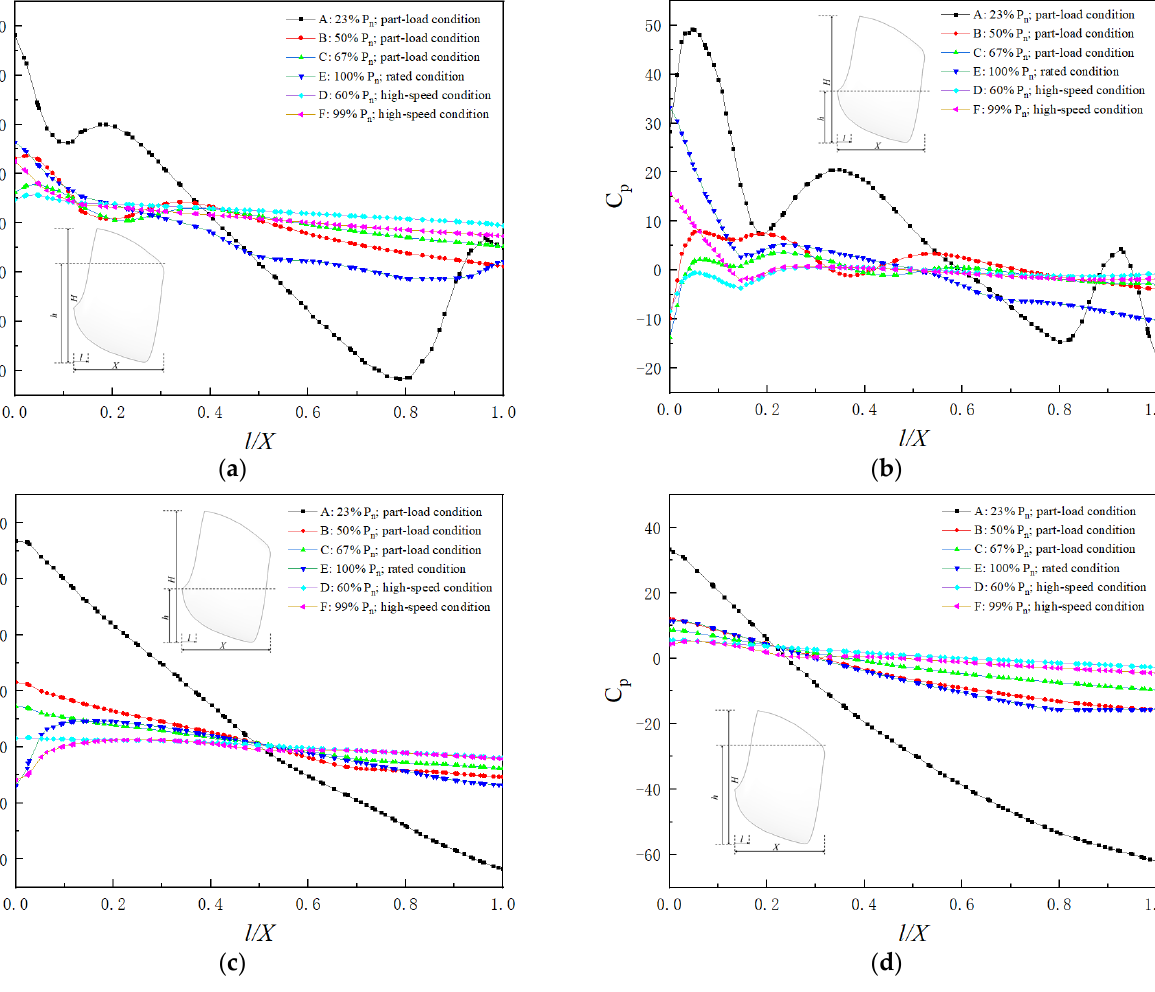
Figure 12. Pressure coefficient of the vanes at different elevations. Note: ( a ) shows the pressure coefficient of the vane’s suction surface at the elevation h/H = 40%; ( b ) shows the pressure coefficient of the vane’s suction surface at the elevation h/H = 75%; ( c ) shows the pressure coefficient of the vane’s pressure surface at the height h/H = 40%; ( d ) shows the pressure coefficient of the vane’s pressure surface at the elevation h/H =